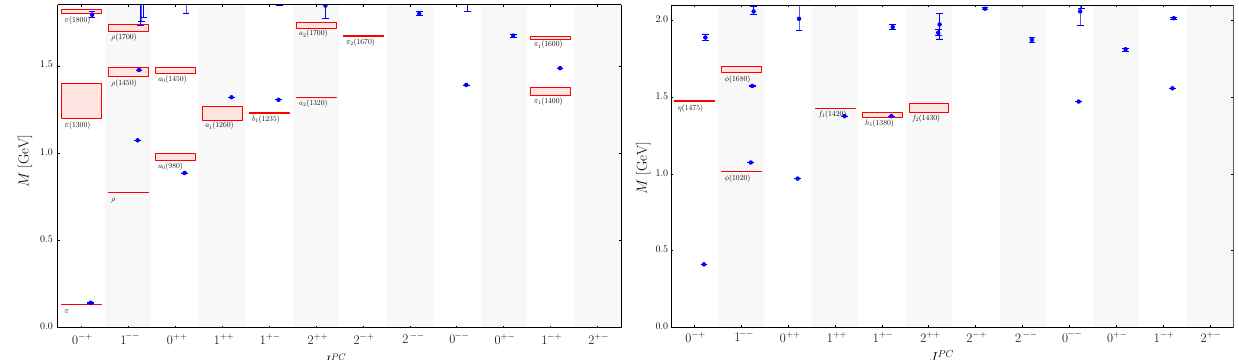
Fig. 3 Light isovector quarkonium (left panel) and strangeonium (right panel) spectra of mesons with J ≤ 2 including exotic quantum numbers, fitted to the splittings ( [ 1 ++